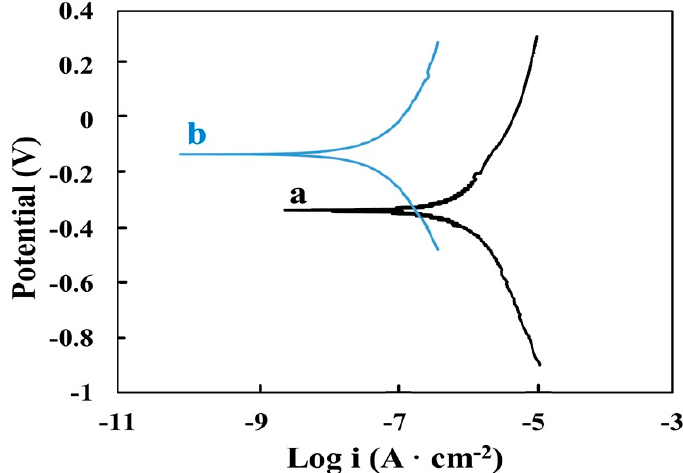
Figure 2. SEM micrographs for a film, prepared from 10 gL − 1 PEMA with 1 gL − 1 LA solution: ( A ) as-deposited and ( B ) after annealing at 180 °C for one hour.